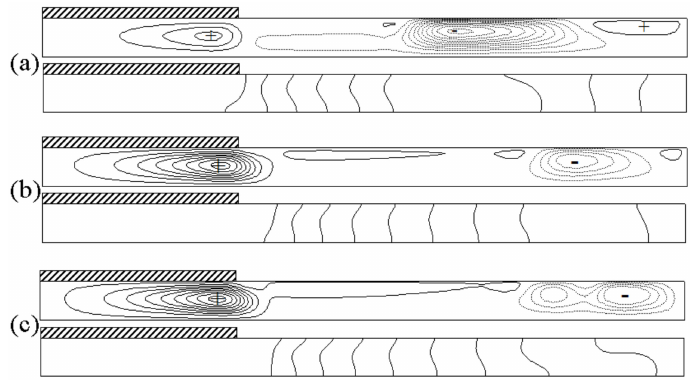
Figure 9. Flow structures and concentration profiles in the meridian plane. ( a ) Re T = 3943, Re s = –561; ( b ) Re T = 3154, Re s = –1123; ( c ) Re T = 3943, Re s = –1123.